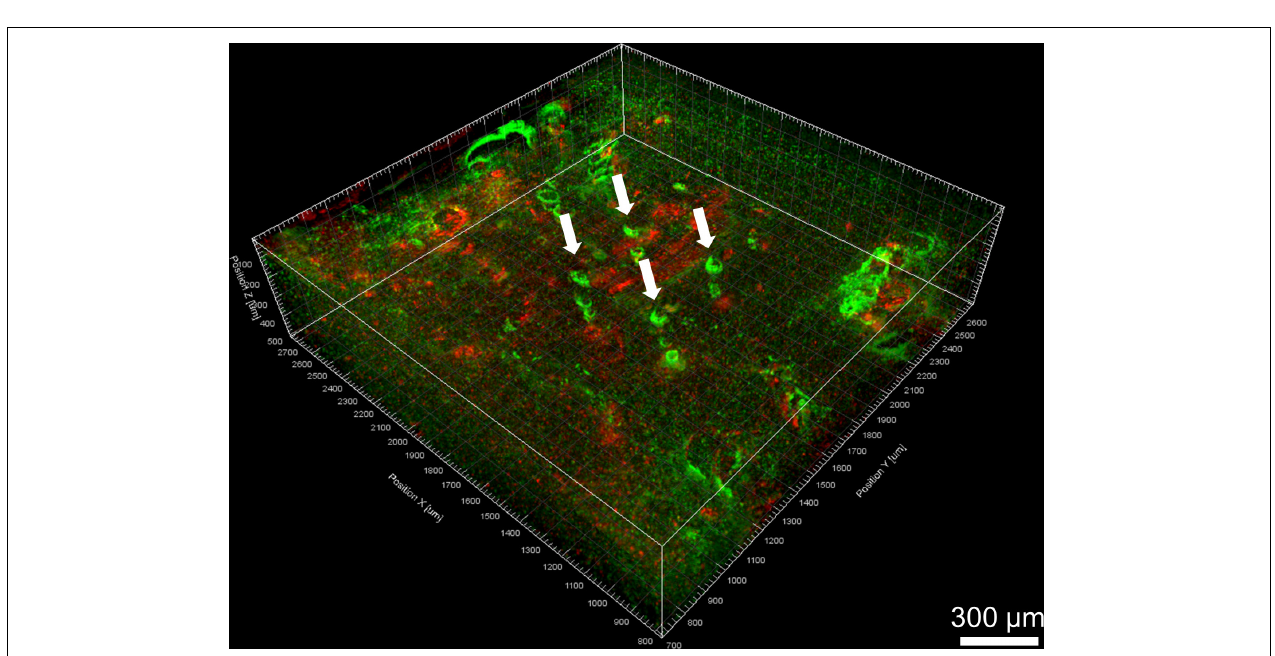
FIGURE 9 | Volume rendering of GFAP (green) and IBA-1 (red) after alignment. Four Blackrock electrode tracks are highlighted with white arrows. The astroglial sheath stained brighter in some sections than others and looks like a series of rings.